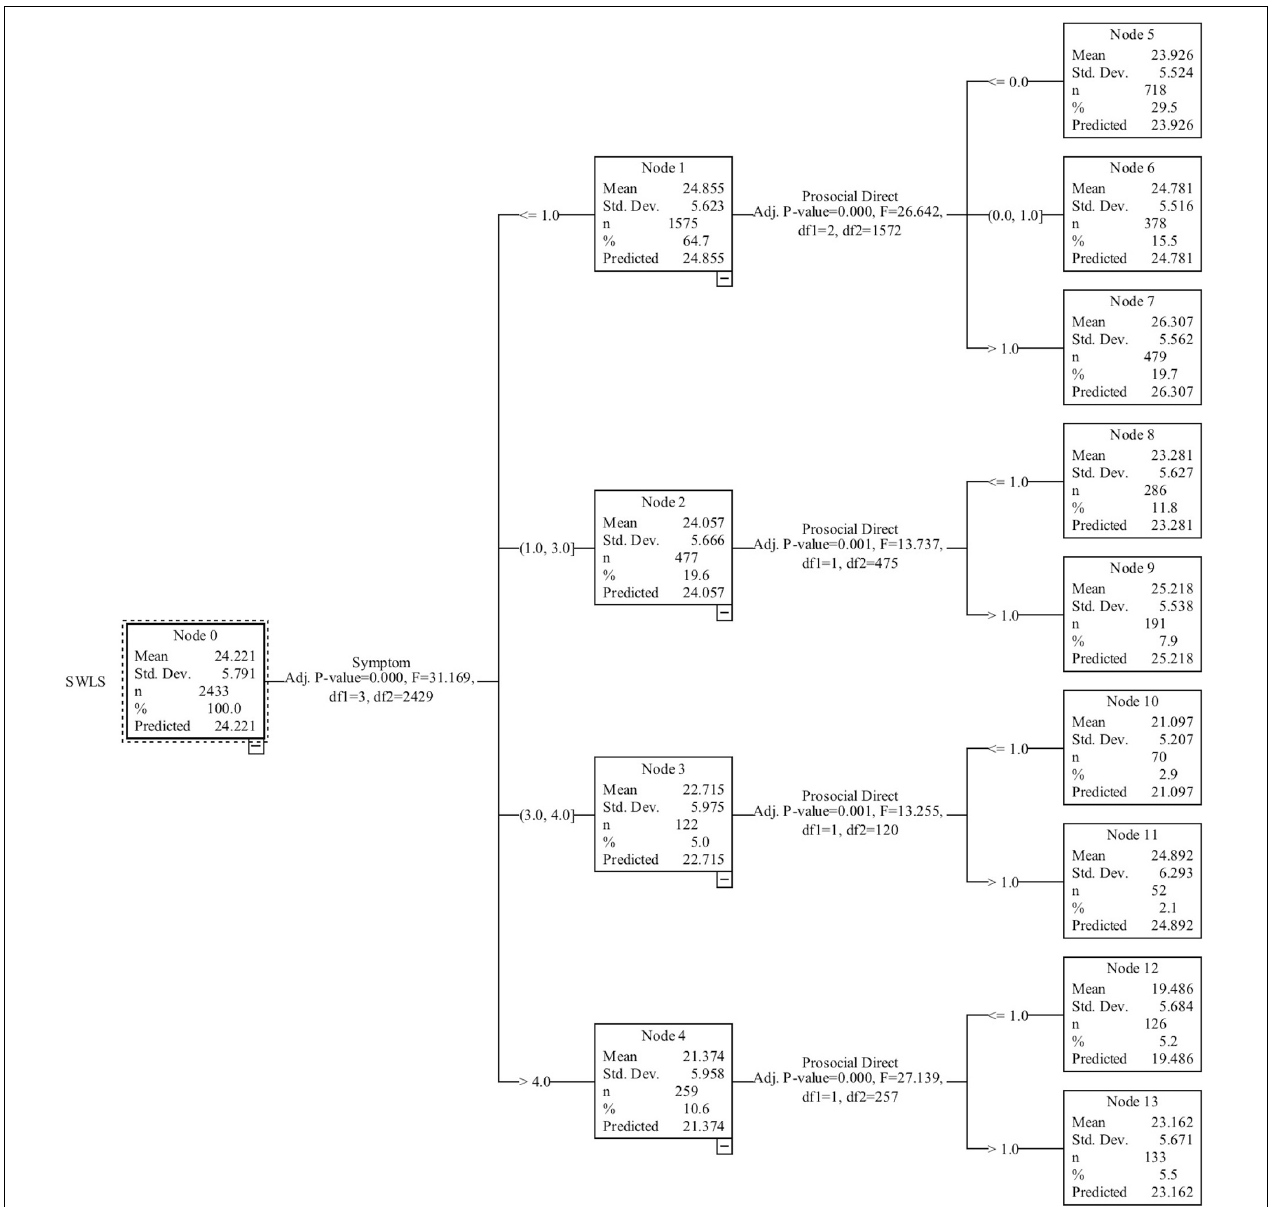
FIGURE 2 | Classification tree of SWLS based on negative emotions and direct